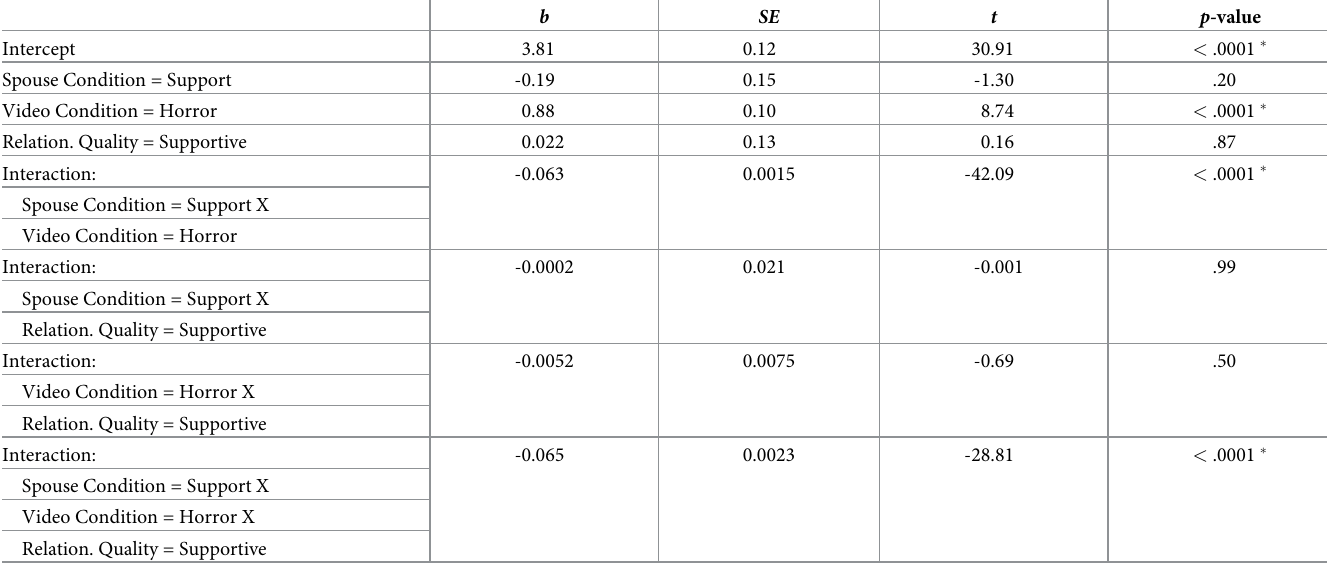
Table 4. Tonic pupil